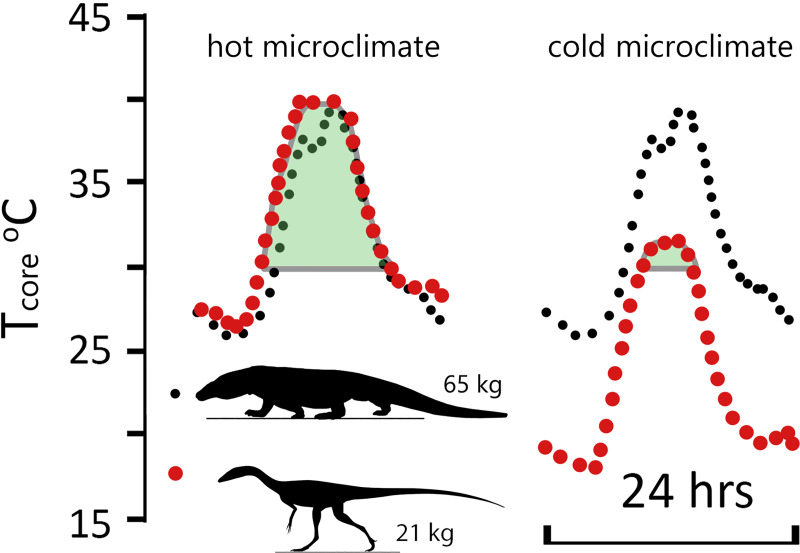
Comparison of daily temperature curves for Varanus and Coelophysis (uninsulated).Daily temperature curves for hot and cold microclimates for the 15th of May (uninsulated Coelophysis) and November (Varanus komodoensis) [40]. There is strong agreement between the low RMR and broad CTR Coelophysis and V. komodoensis in the hot microclimate. Coelophysis modeled in the cold microclimate was significantly cold stressed. Green shaded area represents duration of day with Tcore > 30°C.